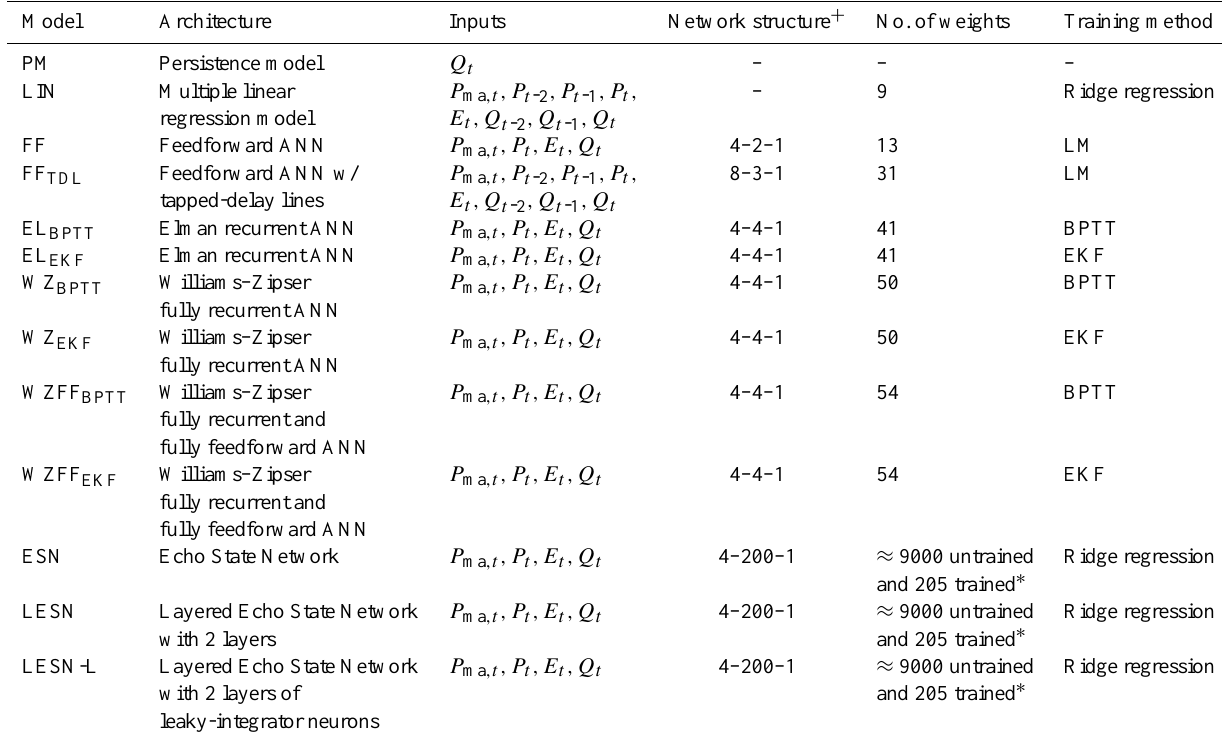
Table 2. Overview of the rainfall–runoff models used.